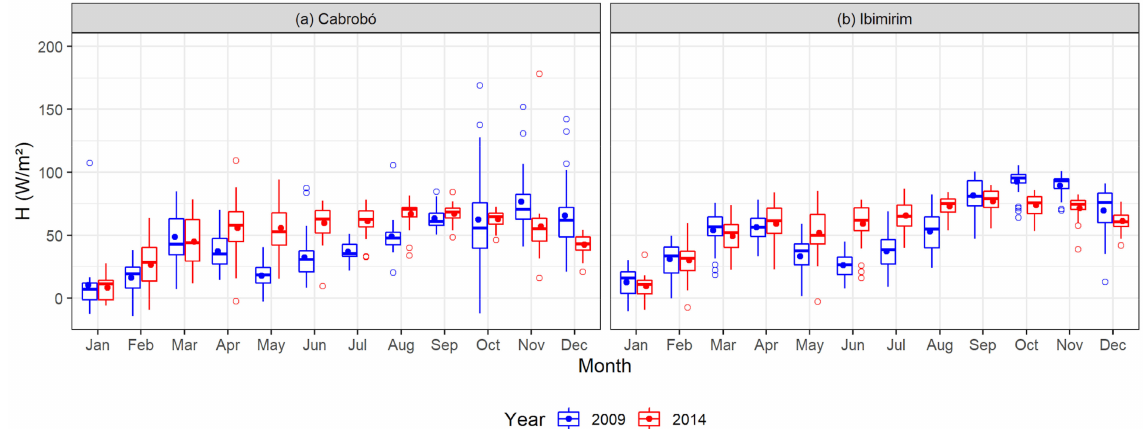
Figure 7. Monthly boxplots of hourly simulated sensible heat flux (H) in the Cabrob ó and Ibimirim sites in 2009 (wet year) and 2014 (dry year).